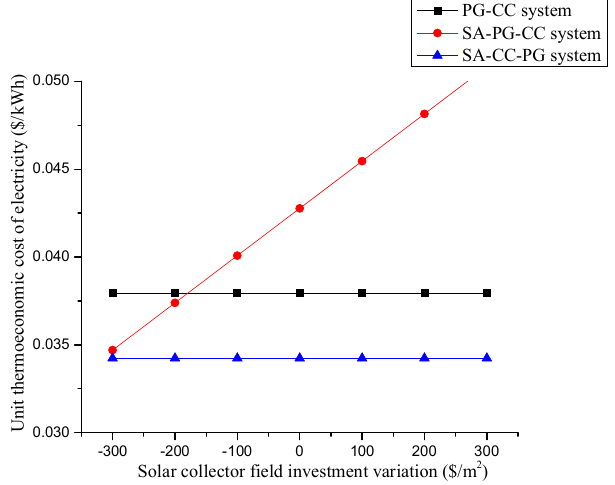
Figure 14. Variation in unit thermo-economic cost of electricity and solar-collector field investment for coal-fired power-generation system with MEA-based CO 2 capture (PG-CC), solar-aided coal-fired power generation with CO 2 capture (SA-PG-CC) and solar-aided CO 2 capture coal-fired power generation (SA-CC-PG).